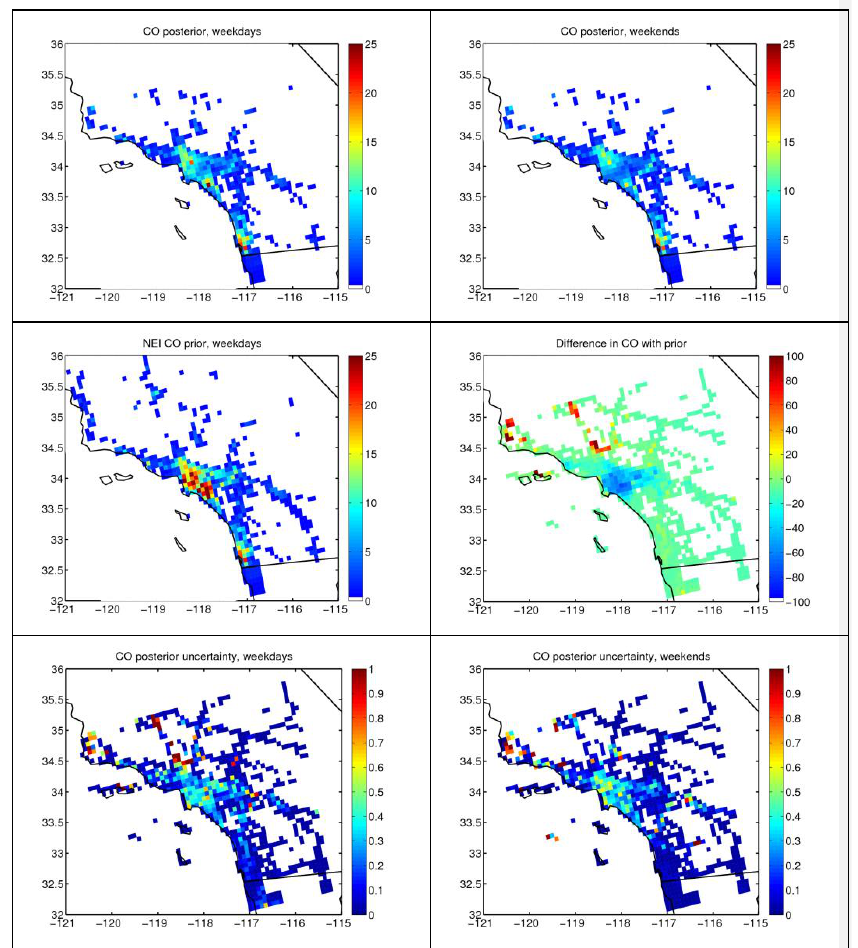
Fig. 3. Daytime average surface flux of CO during weekdays (10 − 9 kgs − 1 m − 2 , top left) and weekends (top right); daytime average surface flux of CO in the NEI 2005 inventory (middle left); difference between the weekday posterior and NEI prior CO estimates (middle right); fractional uncertainties in the posterior during weekdays (bottom left) and weekends (bottom right).